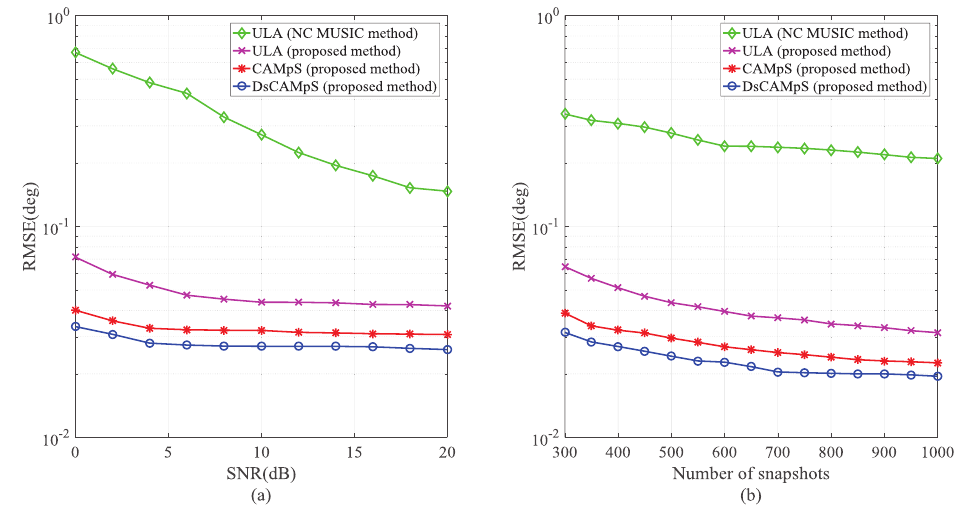
Figure 9. Estimation precision ( Q = 25): ( a ) RMSE versus SNR; and ( b ) RMSE versus the number of